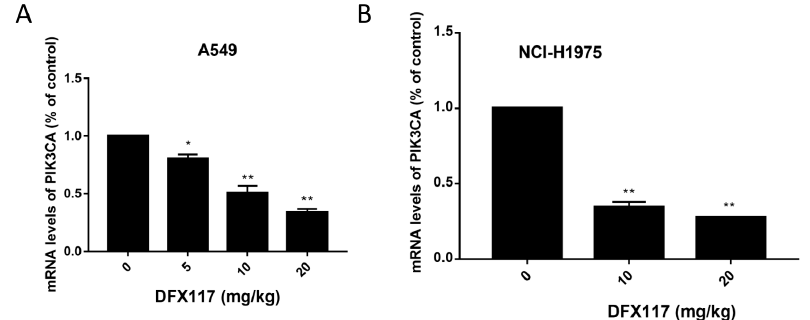
Figure A1. DFX117 decreased the mRNA levels of PIK3CA in A549 and NCI-H1975 xenograft model. ( A ) DFX117 decreased the mRNA levels of PIK3CA in A549 xenograft in athymic mice. ( B ) DFX117 decreased the mRNA levels of PIK3CA in H1975 xenograft in athymic mice. The total RNA of the tumor tissue was isolated with TRI reagent (Invitrogen, Grand Island, NY, USA). mRNA expression of PIK3CA were detected by real-time PCR using β -actin as a reference gene. Data are presented as the mean fold changes ± SD of three independent experiments. * p < 0.05, ** p <